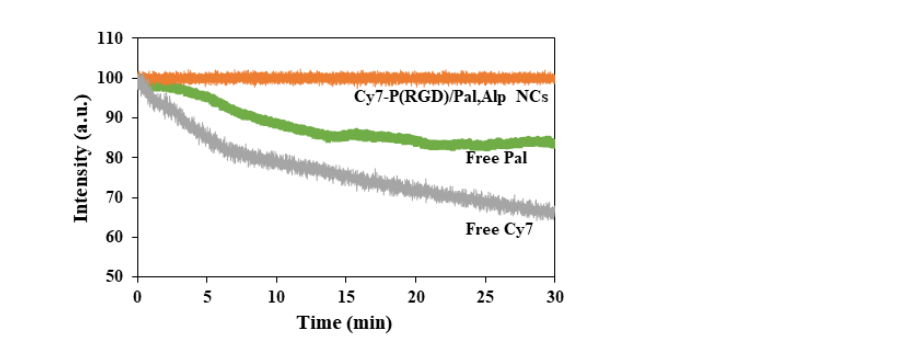
Figure 8. Photostability of Cy7-P(RGD)/Pal,Alp NCs (orange line), free Cy7 (gray line) and free Pal (green line) as a function of time. Fluorescence intensities were recorded after illumination with a xenon flash lamp for 30 min.